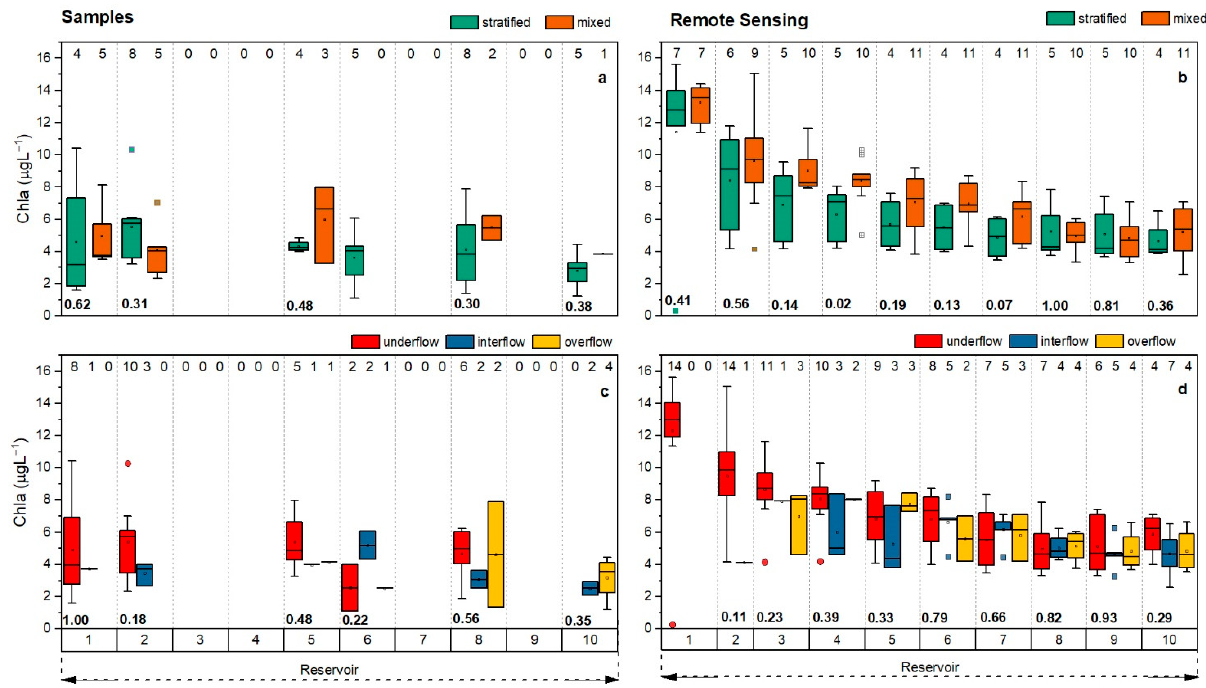
Figure 8. Box plots of chla concentrations observed during mixed (green) and stratified (orange) conditions from ( a ) laboratory analyses of water samples and ( b ) remote sensing estimates. Box plots of chla concentrations observed for different types of density currents: ( c ) laboratory analyses and ( d ) remote sensing. Each color represents one group according to the legends. Numbers at the bottom are the p -value of the Kruskal–Wallis test between the two groups within the section with the null hypothesis that both groups come from the same distribution.